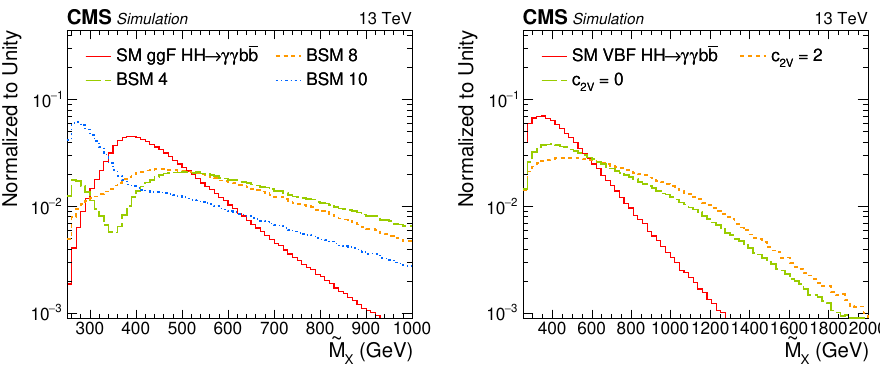
Figure 3 . The invariant mass distributions of the reconstructed Higgs boson candidates m and m (right) in data and simulated events. Data, dominated by the γγ + jets and γ + jets jj backgrounds, are compared to the SM ggF HH signal samples and single H samples ( ttH , ggH , VBF H , VH ) after imposing the selection criteria described in section 5. The error bars on the data points indicate statistical uncertainties. The HH signal has been scaled by a factor of 10 3 for display purposes.